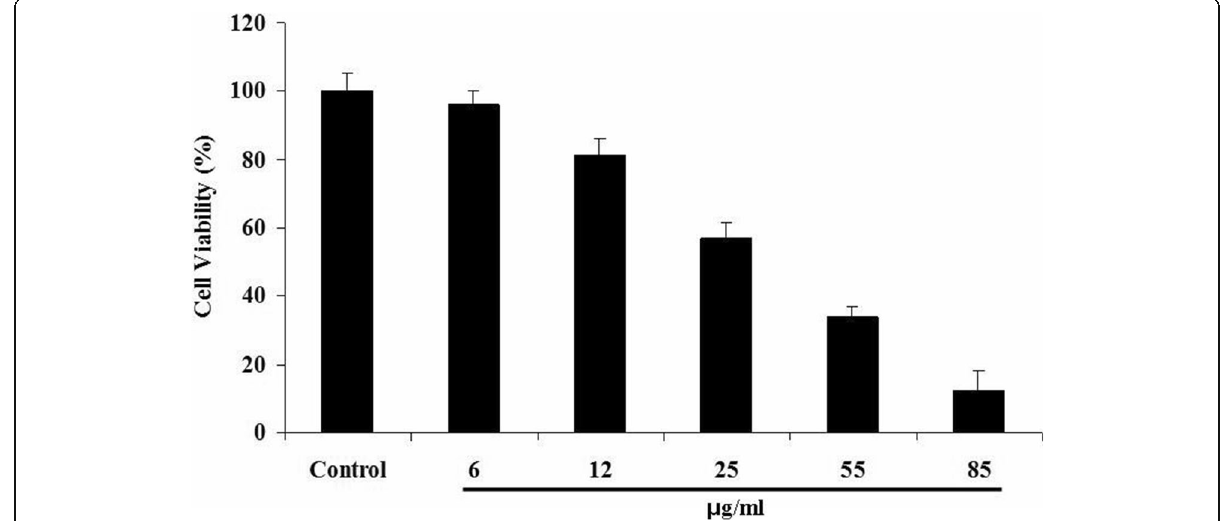
Fig. 3 Cell viability potential of 5-HMP with